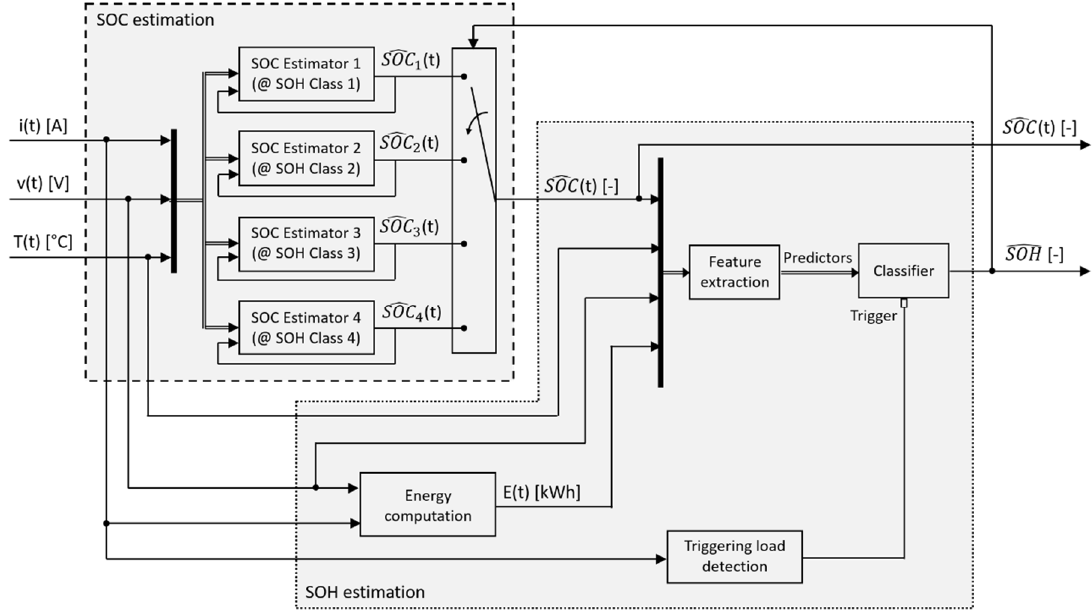
Figure 1. Overall method architecture. Dashed box: state of charge (SOC) estimation. Dotted box: state of health (SOH) estimation. i ( t ) : charging / discharging current. v ( t ) : voltage at battery terminals. T ( t ) : battery temperature. E ( t ) : energy request. SOH classes: 1: (100 ÷ 95)%; 2: (95 ÷ 90)%; 3: (90 ÷ 85)%; 4: (85 ÷ 80)%.